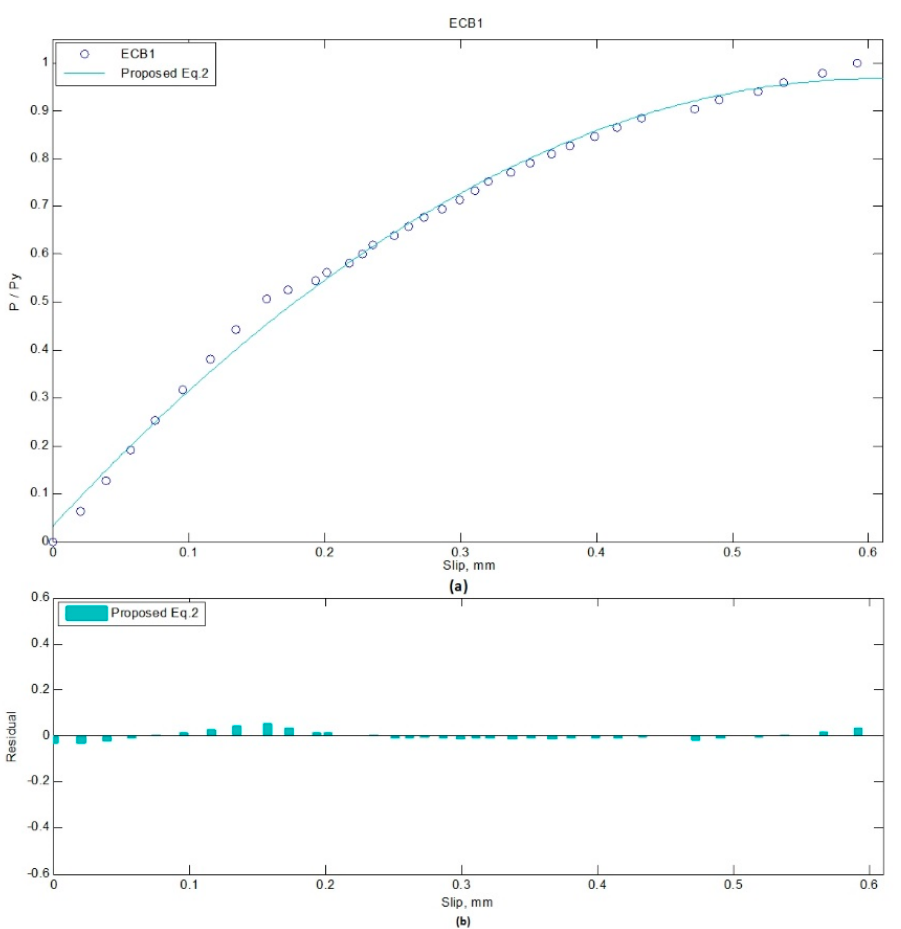
Figure 7. Fitting of curve, ECB1: ( a ) Load-slip; ( b ) Residual-slip.